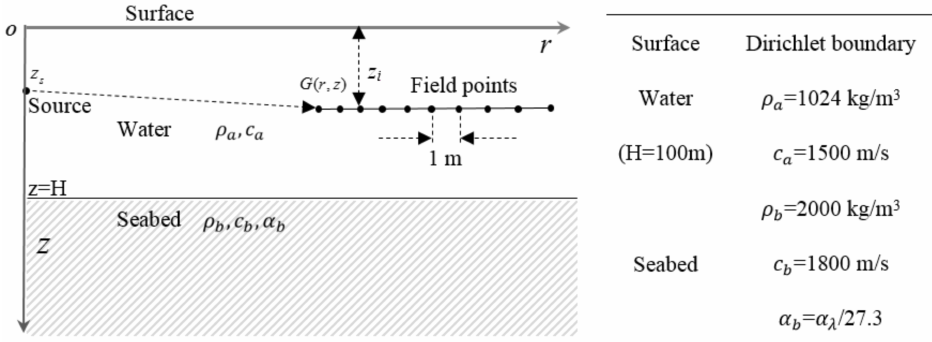
Figure 3. Schematic diagram of the configuration of the Pekeris waveguide.